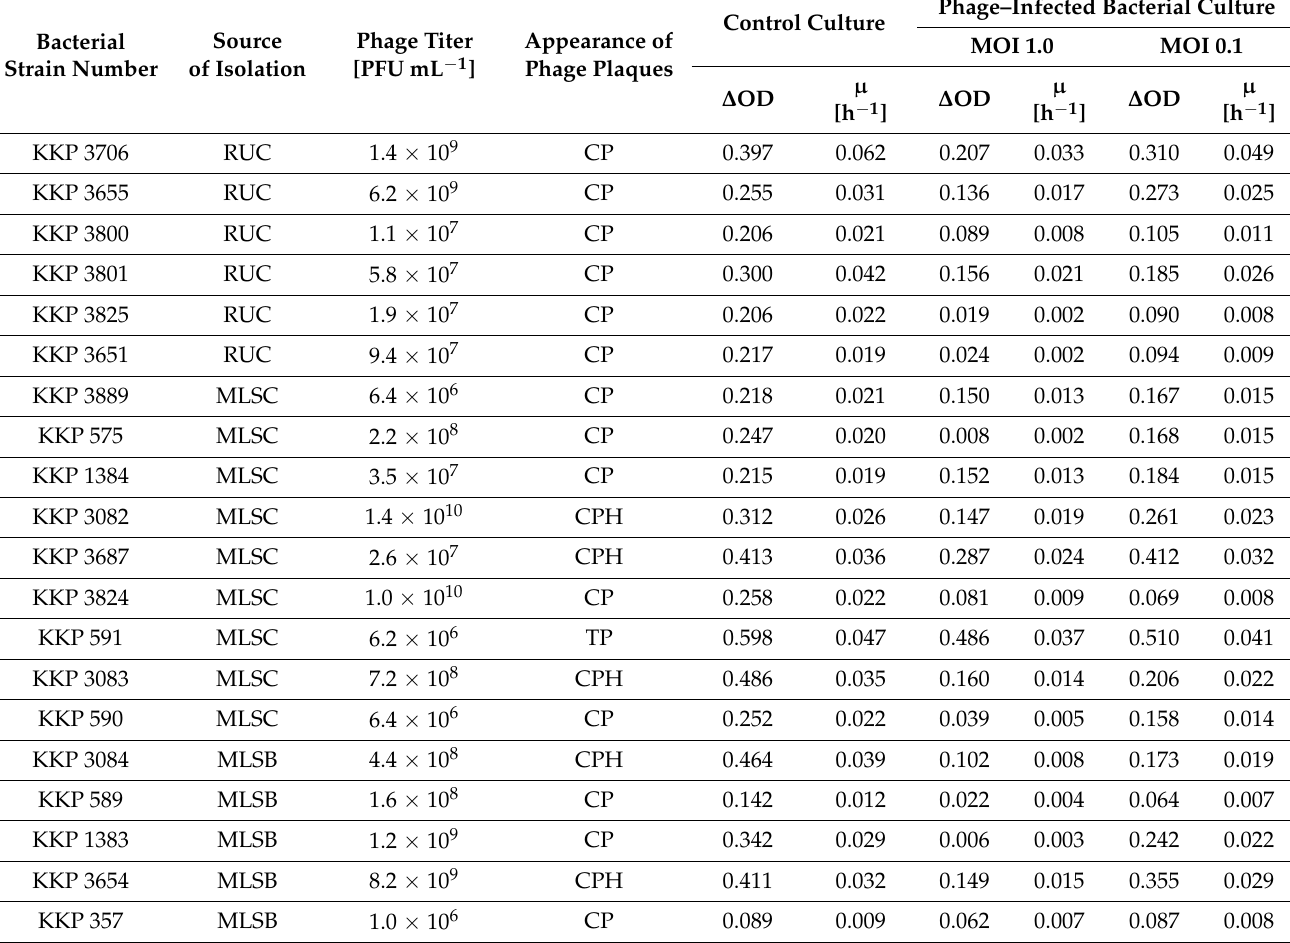
Table 5. Isolated phage titers and values of specific growth rate coefficients of the tested bacteria cultures after the addition of specific phages ( n =